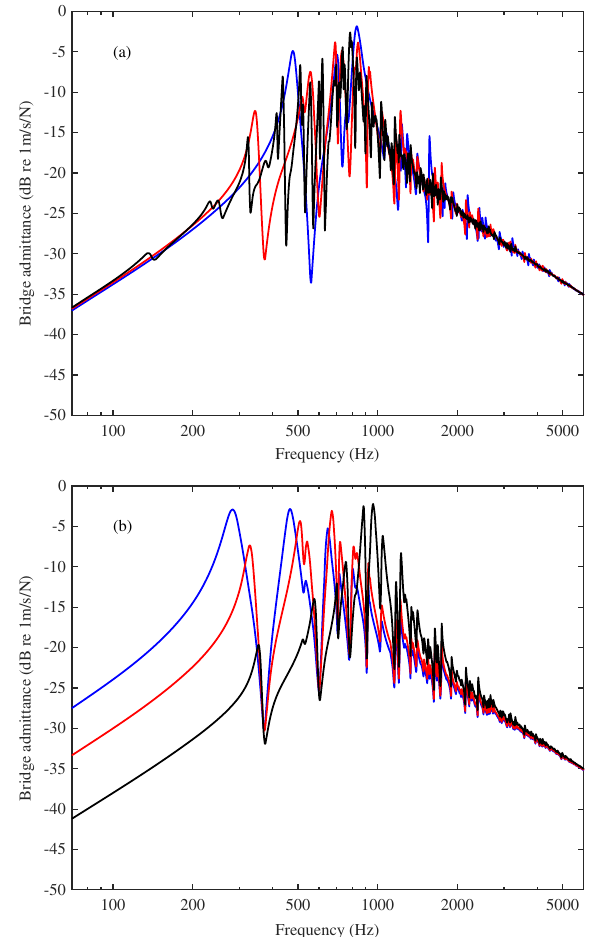
Figure 13. (a) Admittances calculated from the rectangular membrane model, resulting from varying head size by factors 0.75 (blue), 1 (red), 2 (black), corresponding to Sounds F.2, F.3 and F.5 respectively; (b) similar admittances from varying string axial stiffening with values 0 (blue), 10 kN/m (red), 40 kN/m (black), corresponding to Sounds G.8, G.10 and G.13